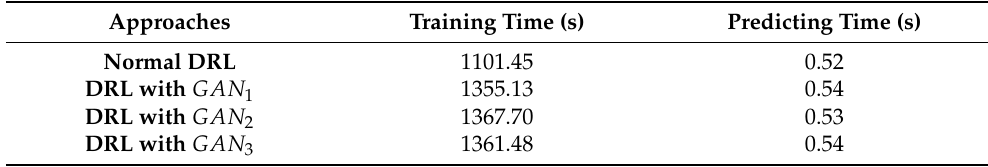
Table 6. Computational time for training and prediction of different